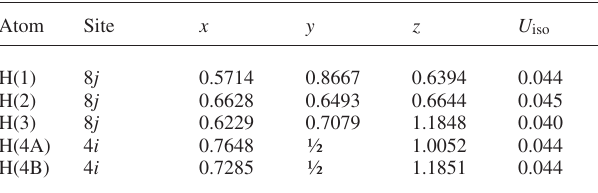
Table 2. Atomic coordinates and displacement parameters (in Å 2 )